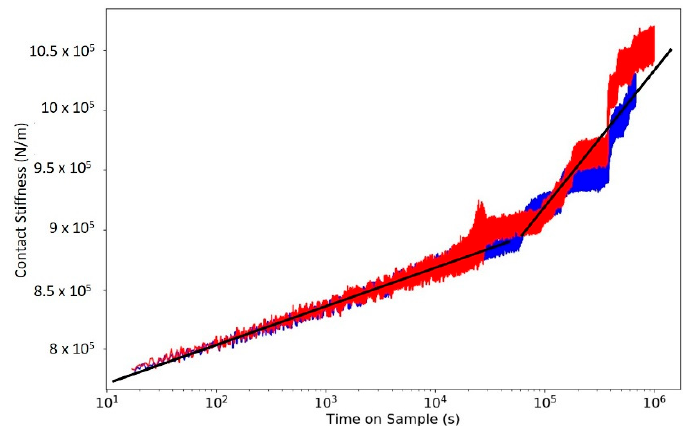
Figure 10. Plot of the same data as in Figure 9 but with time plotted on a logarithmic scale. A steady increase in the contact stiffness is observed for the first ~30,000 s of the test, as observed by the linear fit through the data. However, at longer times, there is a sharp change in the rate of increase of contact stiffness, and deformation is